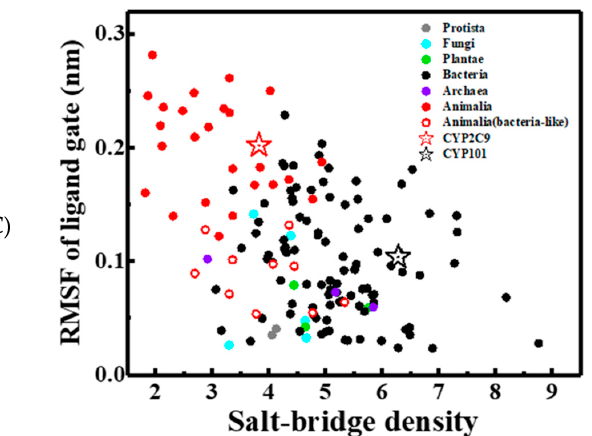
Figure 5. The correlation between the salt-bridge densities, i.e., the number of salt bridges per 100 residues in the protein, with ( A ) the overall internal mobility of the enzyme, defined as the room-mean-squared fluctuation (RMSF), ( B ) the flexibility of the catalytic pocket, defined as the room-mean-squared fluctuation of pocket volume, and ( C ) the flexibility of ligand gating area, defined as the room-mean-squared fluctuation of the distance of the ligand gate from F/G loop to the B’ helix (e.g., the CYP101 was defined by the distance between Ser190 in the F/G loop and Pro89 in the B’ helix). Here, 146 different kinds of CYP450 proteins were studied, and 10 ns MD trajectories were conducted for each protein to obtain these quantities. The data are colored by their biological categories: Fungi (cyan), Archaea (blue), Bacteria (black), Protista (grey), Animalia (red solid spheres), and Plantae (green), with CYP101 and CYP2C9 highlighted by starts and several bacteria-like animal CYP450s labeled by red empty circles. The Pearson Correlation Coefficient [52] for ( A – C ) are − 0.43, − 0.38, and − 0.46, respectively, which are statistically meaningful and qualitatively supports the hypothesis that the salt bridges play an important role in restraining the structural flexibilities for all CYP450 proteins in the